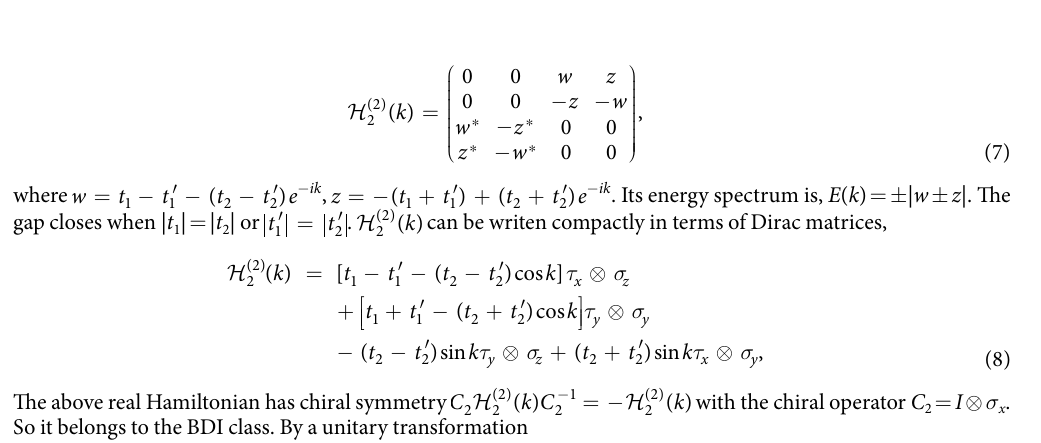
Figure 2. Schematic illustration of the models. ( a ) Eq. (5) (upper) and Eq. (6) (lower). The system of three Majorana chains described by Eqs (12) and (13) is shown separately in ( b – d ). The red (pink) circles represent Majorana fermions α ( β ) and the blue circles represent